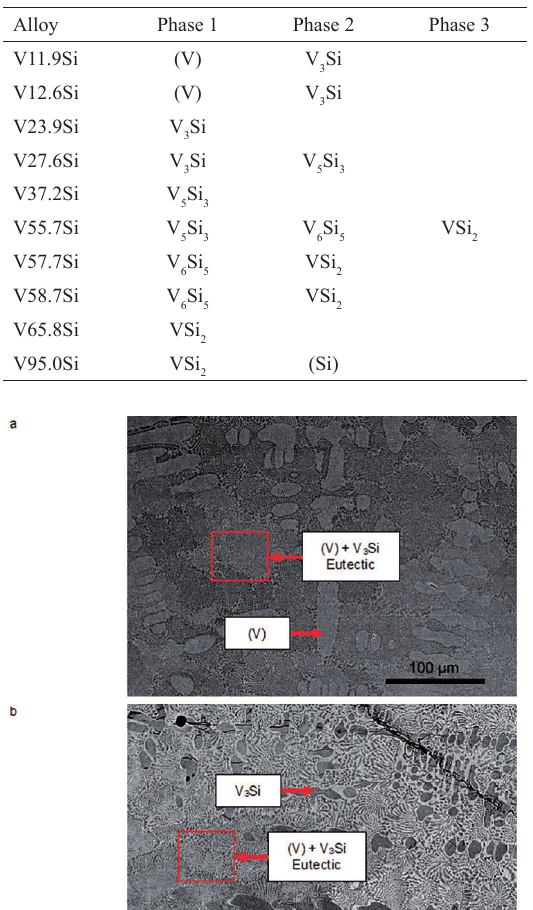
Table 3: XRD identification of the phases present in the alloys produced in this work.